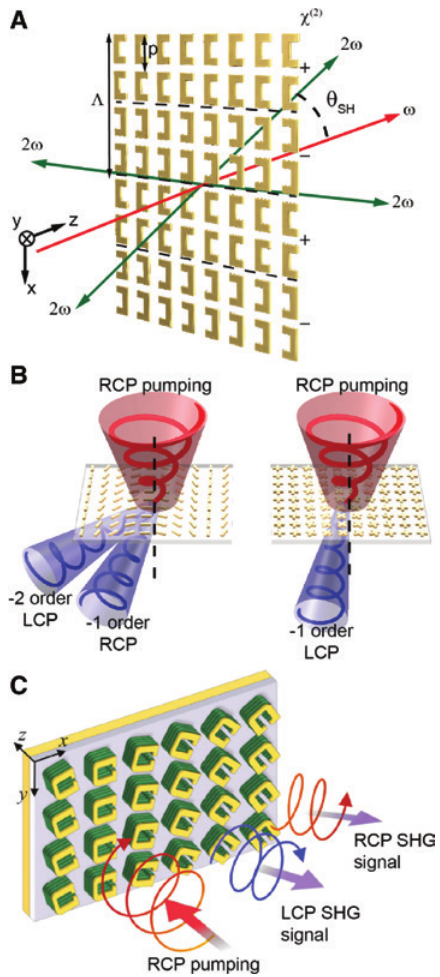
Figure 2: Phase control on nonlinear